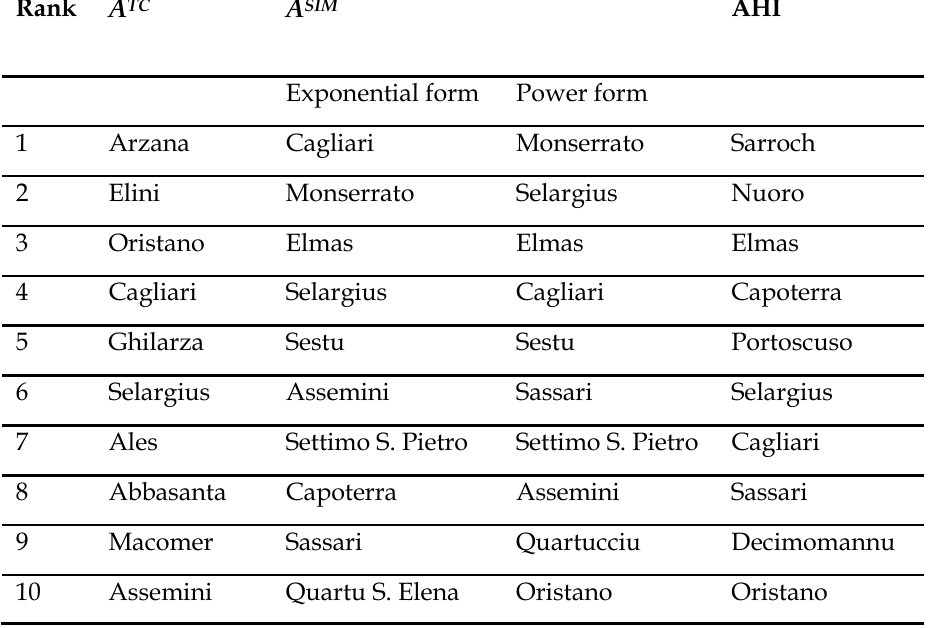
Table 4. Ranking of Sardinian municipalities by their commuters’ accessibility and